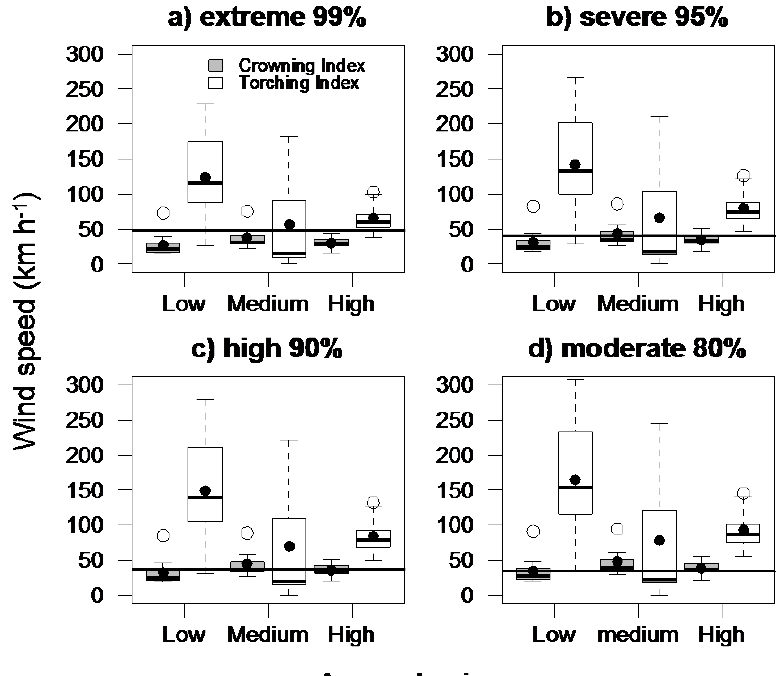
Figure 3. Wind speeds (km·h − 1 ) indicating crowning (CI) and torching (TI) indices across three aspen dominance classes and four fire weather scenarios. For each box plot the box represents the 1st and 3rd quartiles, whiskers denote 1.5 times the interquartile range, the heavy horizontal line inside the boxes indicates the median, filled circles indicate the mean, and unfilled circles indicate outliers. Horizontal bar indicates threshold wind speed based on fire weather data below which extreme fire behavior is likely. Aspen dominance classes: low, 0%–33%, medium, 34%–66%, and high,